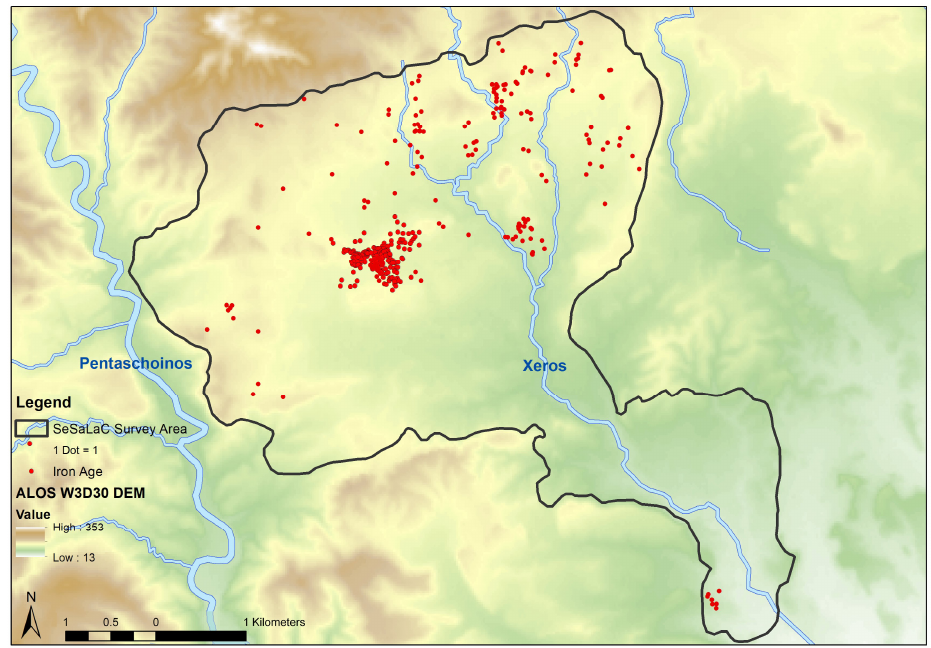
Figure 13. Cypro-Archaic and Cypro-Classical pottery distribution. ALOS DEM are in metres. Digital data courtesy of the Geological Survey Department, Republic of Cyprus (Map by Charalambos